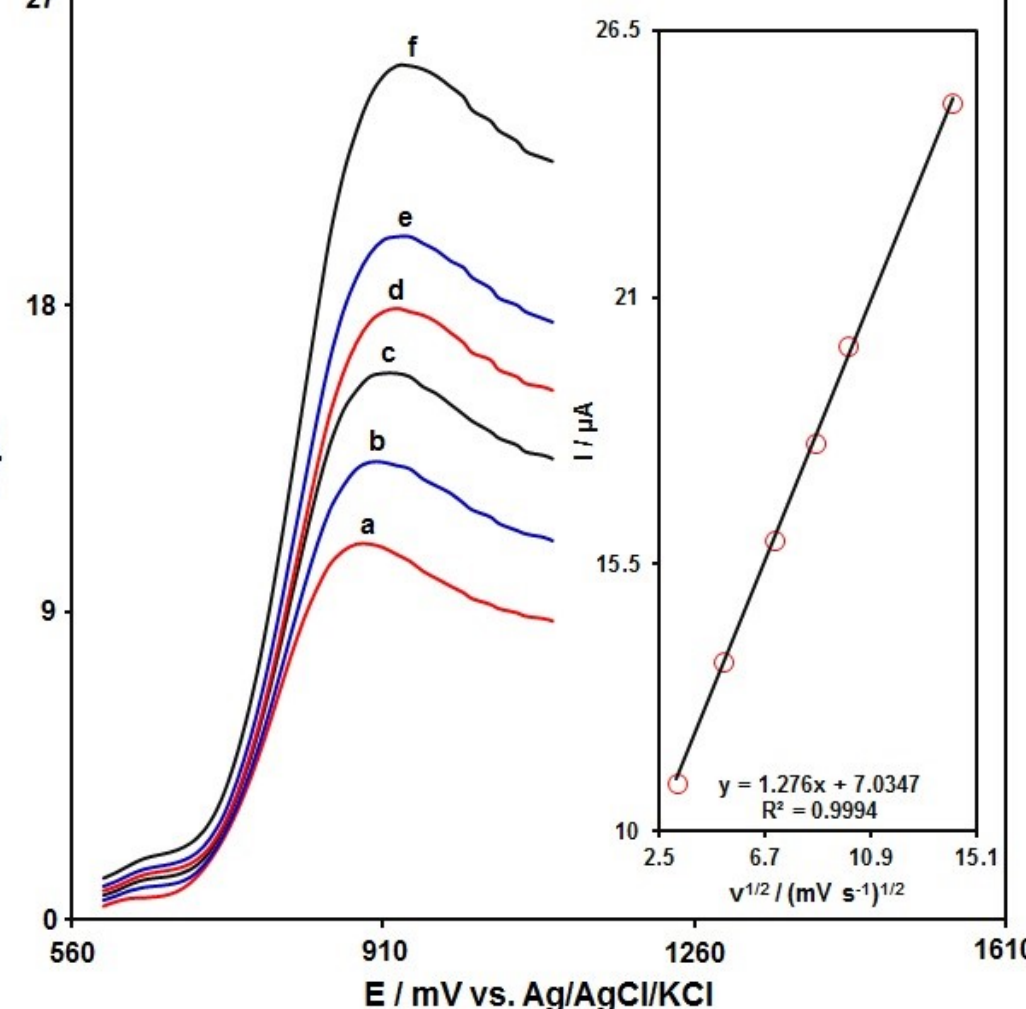
Figure 7. LSV captured for MnO 2 NR-IL/CPE in PBS (0.1 M) at the optimized pH value of 7.0 under exposure to 5.0 μ M of SAA at various scan rates; the curves nos. a to f correspond to 10, 25, 50, 75, 100 and 200 mV/s, sequentially; Inset: changes in anodic peak currents against v 1/2 .